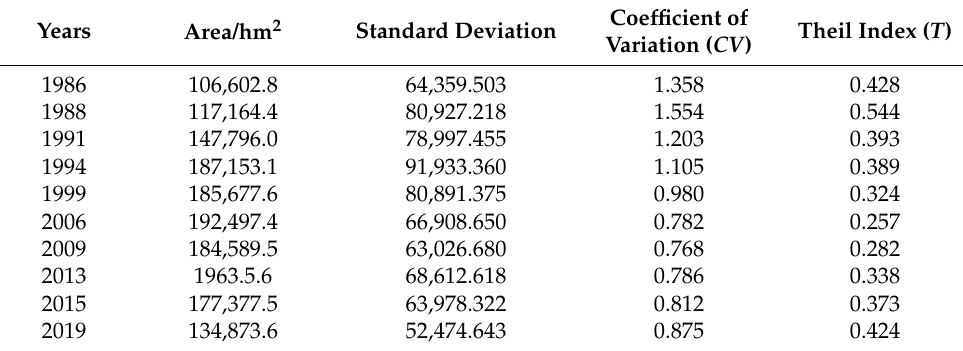
Figure 9. Fluctuation of three statistical indices compared to the areal changes of fish ponds from 1986 to 2019. ( A ): Theil index ( T ); ( B ): coefficient of variation ( CV ). ( C ): standard deviation ( SD ). Table 1. Statistical results of fish ponds in GBA from 1986 to 2019.